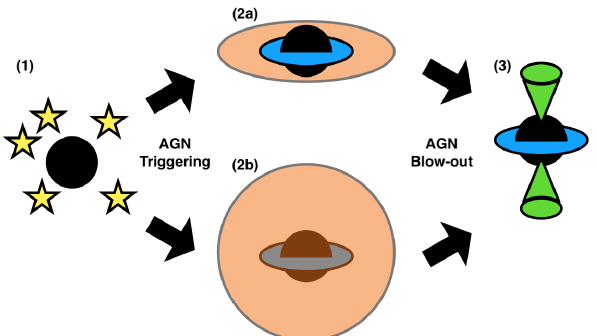
Figure 3. Schematic of plausible black hole evolutionary paths along the galaxy merger